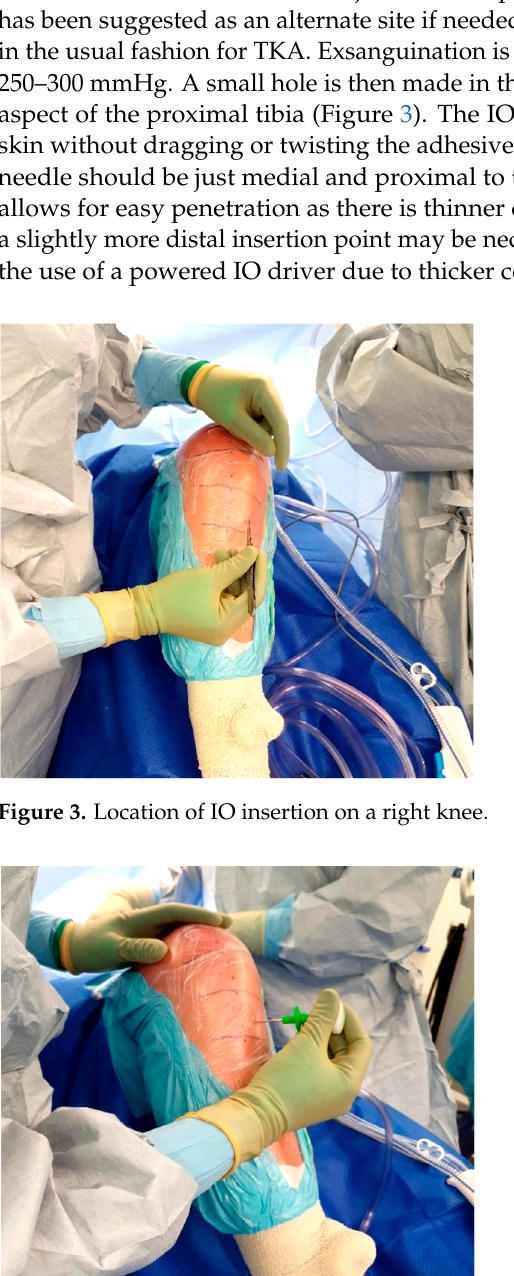
Figure 2. Solution prepared in 50 mL syringes.